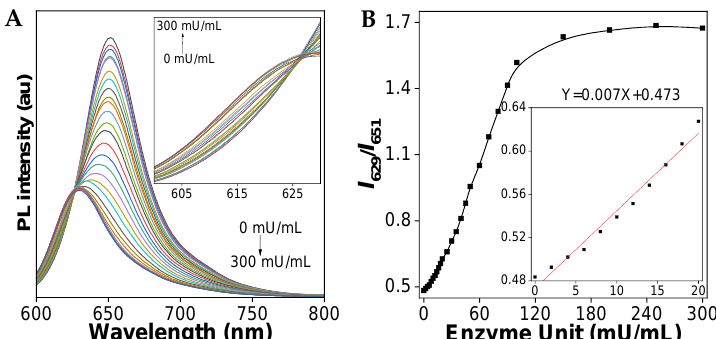
Figure 3. ( A ) PL spectra of TCFISE (5 μM) upon the addition of CaE at 37 °C for 20 min. The inset shows the PL spectra in the range of 600 – 630 nm. ( B ) Relative PL intensity ratios ( I 629 / I 651 ) of TCFISE (5 μM) as a function of CaE concentration. The inset shows the plot and linear fitting of relative PL intensity ratios ( I 629 / I 651 ) vs. the concentration of CaE (0 – 20 mU/mL). λ ex = 575 nm.